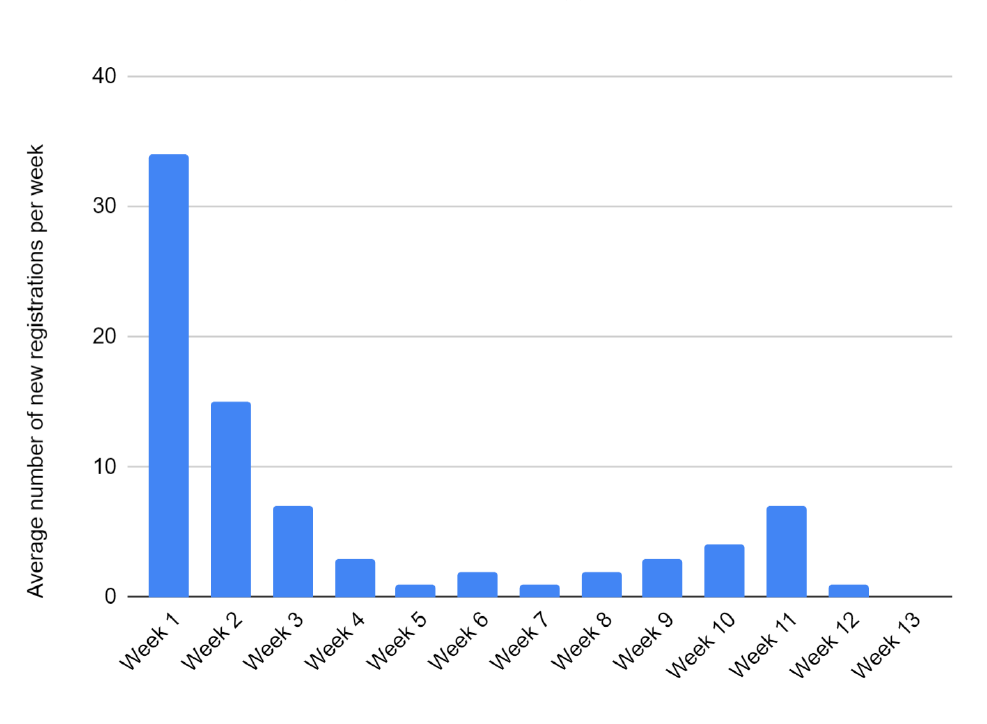
Figure 5. Number of newly registered user accounts, per